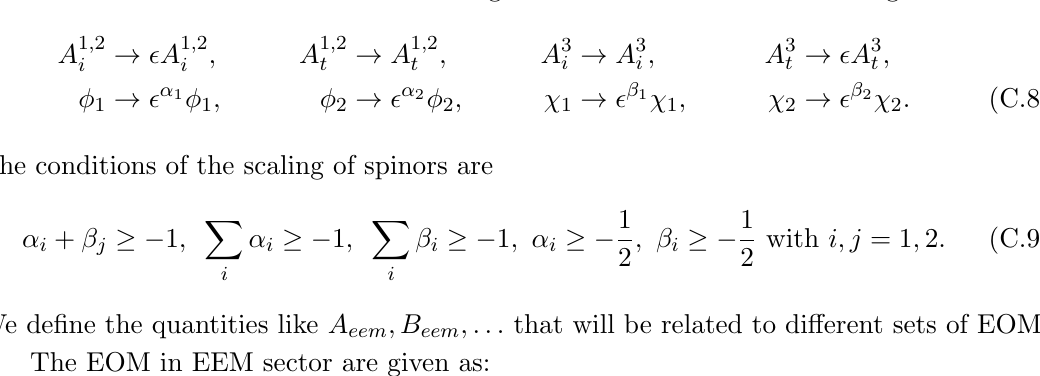
Table 2. Scaling of spinors in EEM sector: [1,2] satisfy (cid:12) 1 ; 2 (cid:0) (cid:11) 1 ; 2 = 1; [3,4] satisfy (cid:12) 1 (cid:0) (cid:11) 1 = 1 and (cid:11) 2 (cid:0) (cid:12) 2 = 1; [5,6] satisfy (cid:11) 1 ; 2 (cid:0) (cid:12) 1 ; 2 = 1; [7,8] satisfy (cid:11) 1 (cid:0) (cid:12) 1 = 1 and (cid:12) 2 (cid:0) (cid:11) 2 = 1 along with (C.9). EEM